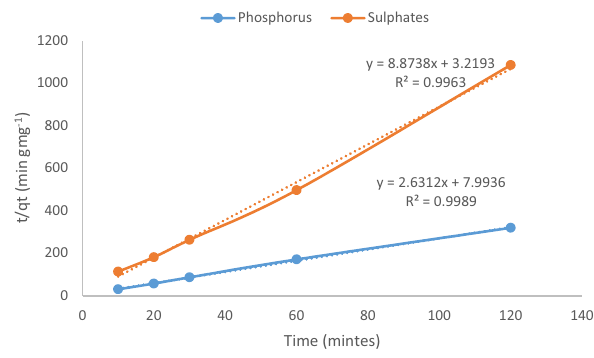
y = 8.8738x + 3.2193 R² = 0.9963